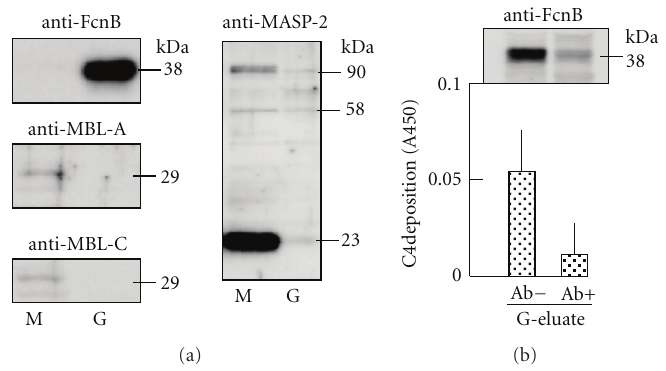
Figure 2: : GlcNAc-agarose chromatography of bone marrow fluids from FcnA − / − mice. (a) Western blot of FcnB, MBL-A, MBL-C, and MASP-2/sMAP in the mannose (M) and GlcNAc (G) eluates from GlcNAc-agarose chromatography under reducing conditions. Right panel: 90kDa, 58 kDa, and 23kDa bands represent the proenzyme form of MASP-2, the heavy chain of MASP-2, and sMAP, respectively. For each sample, 60 μ L equivalent to the original volume of bone marrow tissue was loaded per lane. (b) C4-deposition activity of the GlcNAc eluate on GlcNAc-BSA-coated microplates. Before assessment, the GlcNAc eluate was passed through anti-FcnB Ab-coupled Sepharose 4B (Ab+) or not (Ab − ). The activity of a 30 μ L sample equivalent to the original bone marrow tissue was determined in quadruplicate (mean ± SD). Inset: western blot of FcnB in the eluates used for C4 deposition.